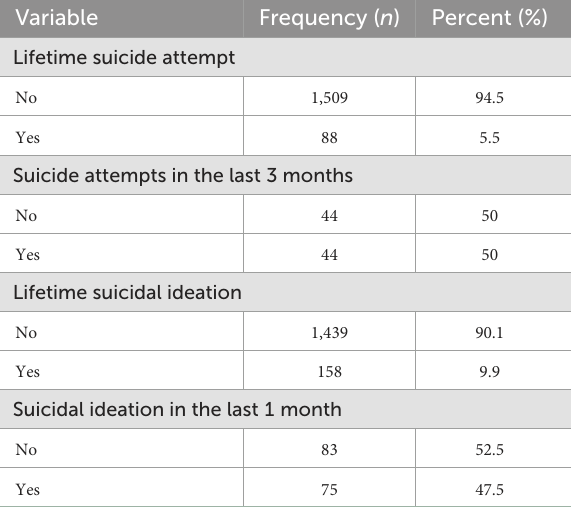
TABLE 4 Magnitude of suicide attempts among youths living in the central, west, and north Gondar